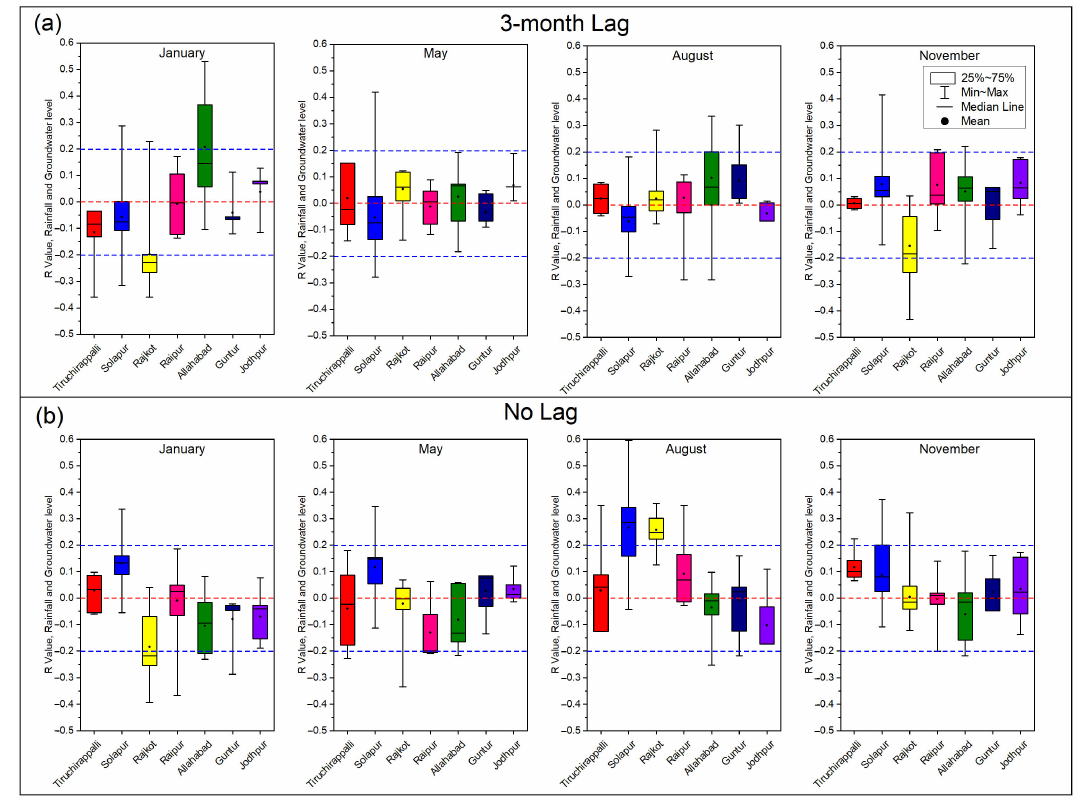
Figure 8. Correlation analysis between rainfall and groundwater level for ( a ) a 3-month recharge lag and ( b ) no lag in